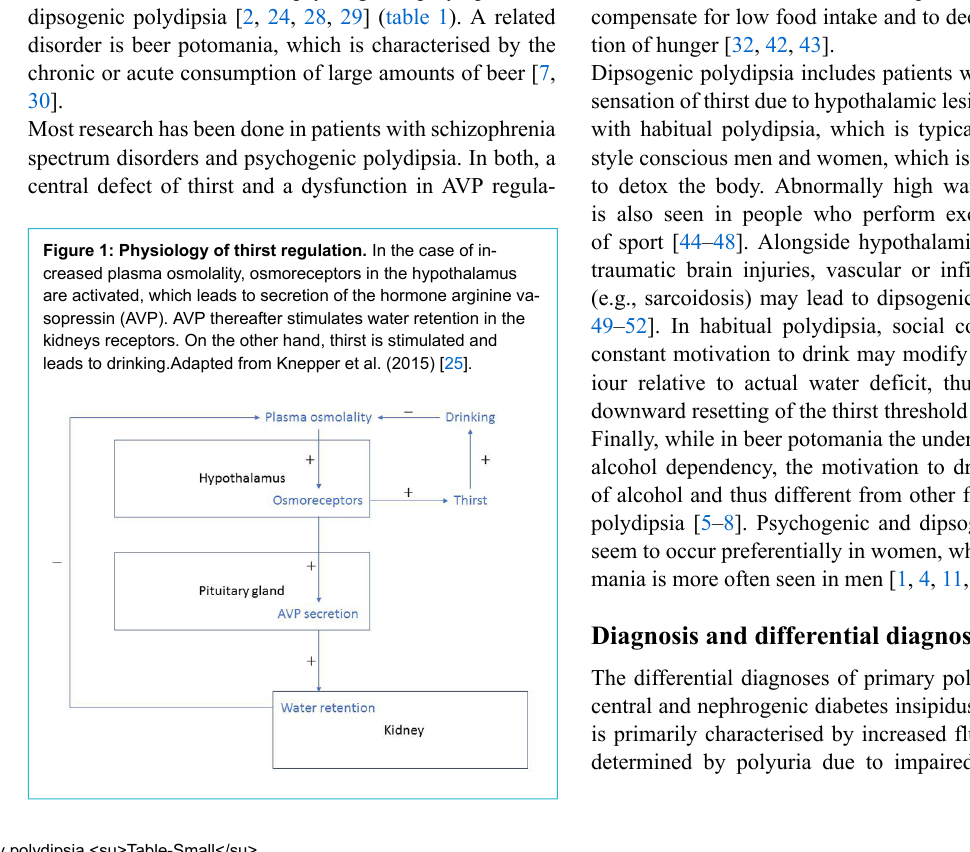
Table 1: Causes of primary polydipsia.<su>Table-Small</su> Primary polydipsia (excessive water intake) Psychogenic polydipsia (e.g., in patients with acute psychosis, chronic schizophrenia spectrum disorder, anxiety disorder, depression, anorexia nervosa and depen- dency disorder) Dipsogenic polydipsia Habitual